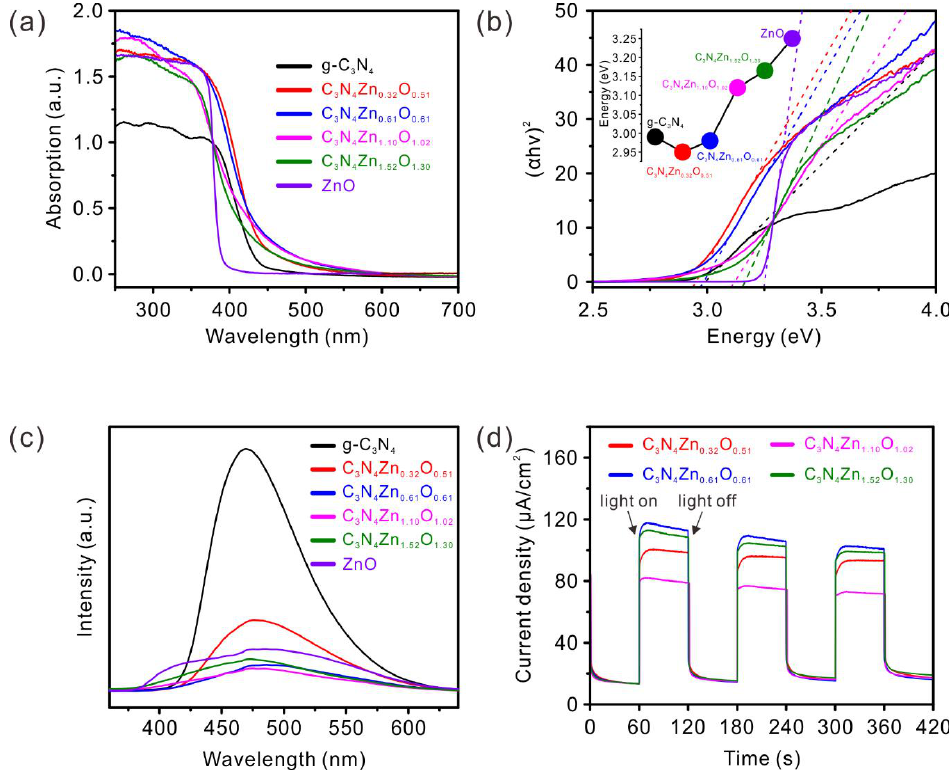
Figure 3. ( a ) UV-Vis absorption spectra of g-C 3 N 4 , C 3 N 4 Zn x O y , and ZnO samples. ( b ) Tauc plot of g-C 3 N 4 , C 3 N 4 Zn x O y , and ZnO samples, appropriate for evaluating optical band gap energies of